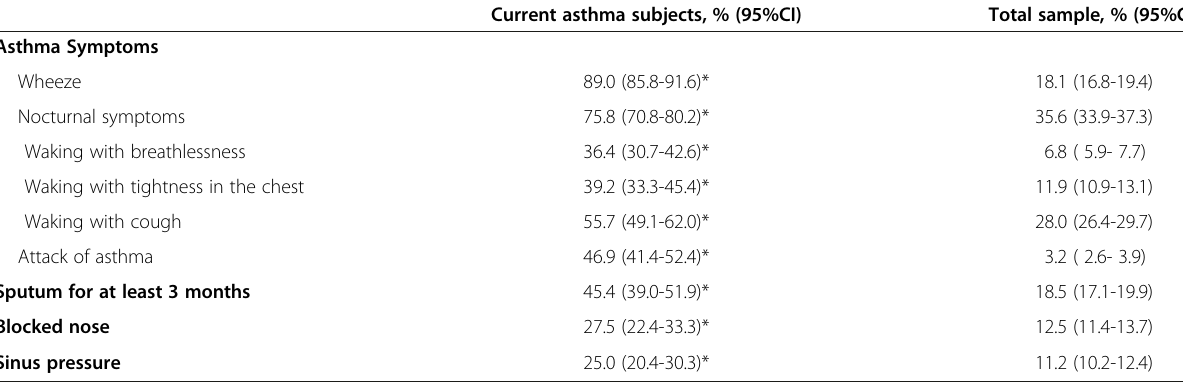
Table 4 Prevalence of self-reported symptoms in last 12 months for ‘ Current asthma ’ subjects(n =450) and total sample(n=